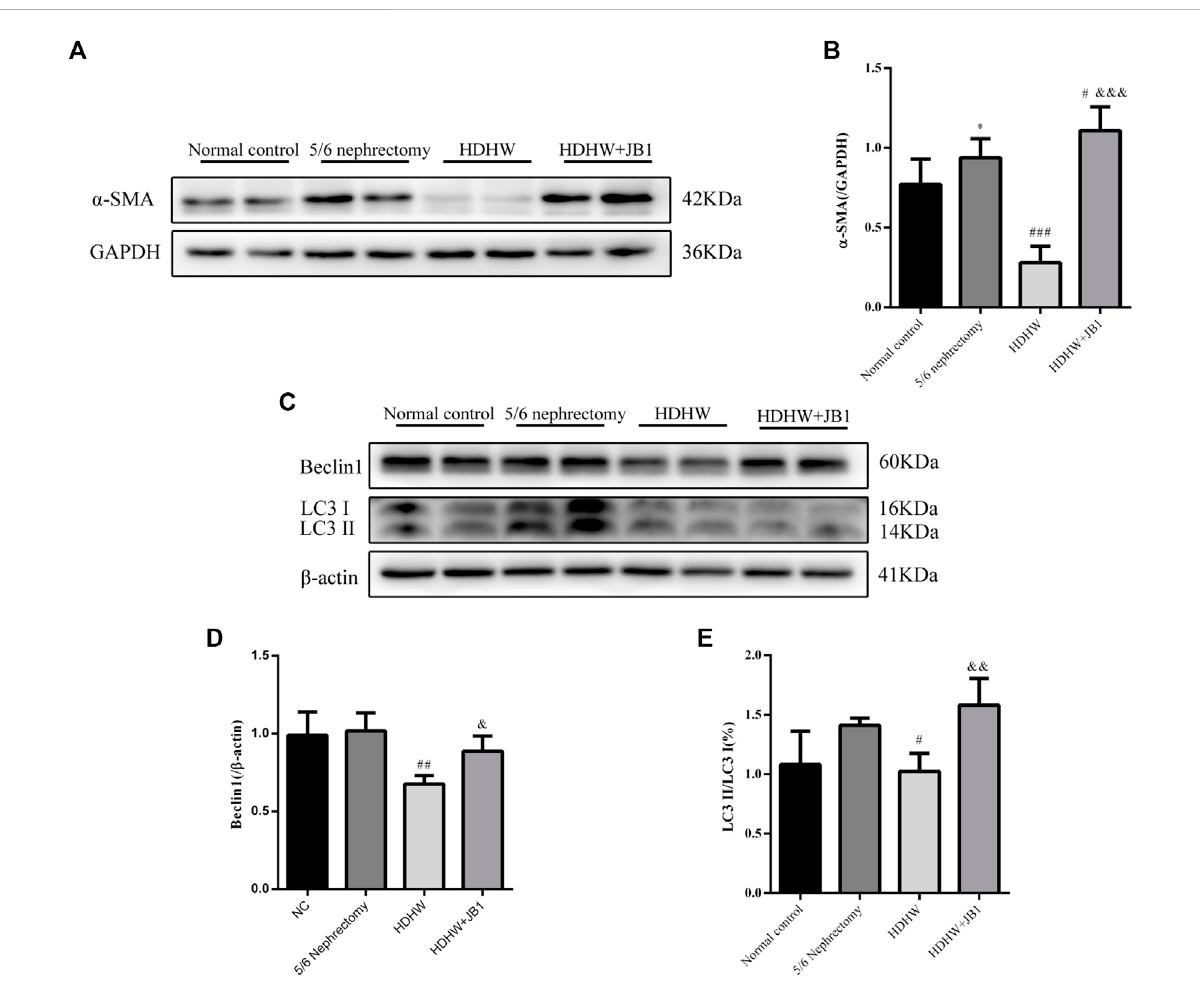
FIGURE 6 IGF-1Rinhibitor(JB1)blockstheinhibitoryeffectofHeidihuangWan(HDHW)onrenal fi brosis andautophagy. (A,C) WesternBlottingforprotein levels of α -SMA, Beclin1, LC3II. (B,D,E) Protein concentration analysis. Data are presented as mean ± SD, n = 3. The data are expressed as * p < 0.05: comparedwithnormalcontrolgroup;# p < 0.05,## p < 0.01,### p < 0.001:comparedwith5/6nephrectomygroup;& p < 0.05,&& p < 0.01,&&& p < 0.001: compared with HDHW group,